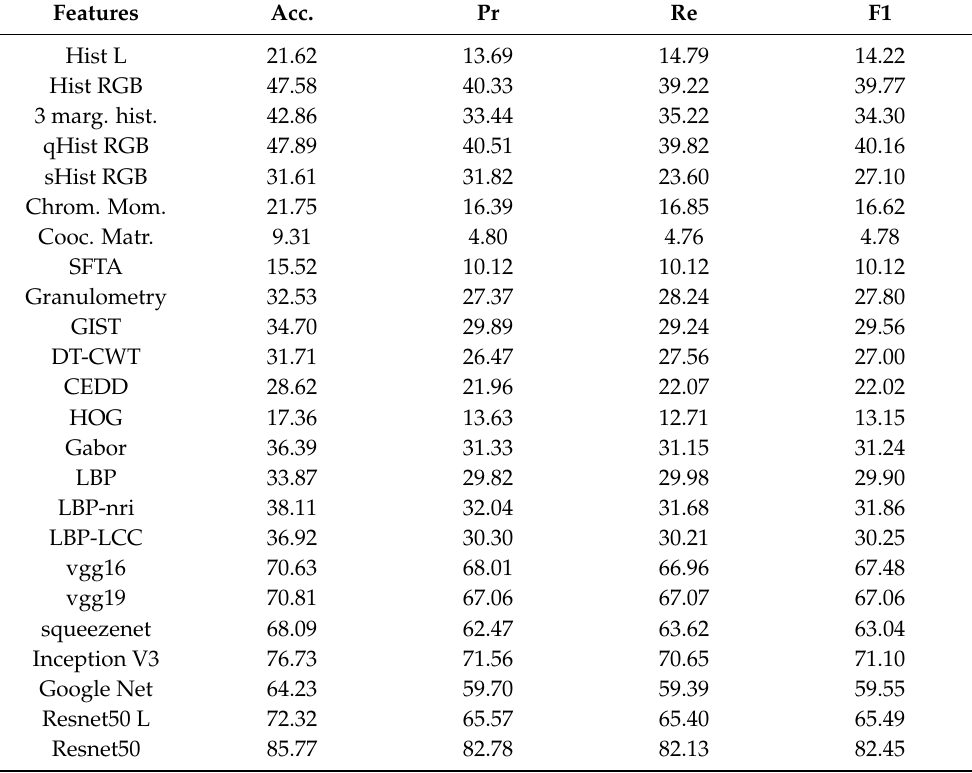
Table 3. Benchmark using 1-NN (266